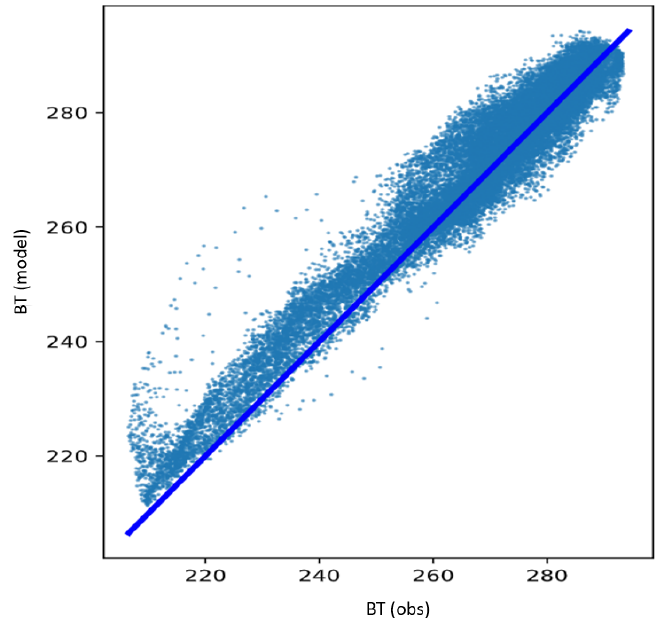
Figure 3. Scatter plot of the observed and model forecast IR BT. The blue line indicates the positions for obs = model.